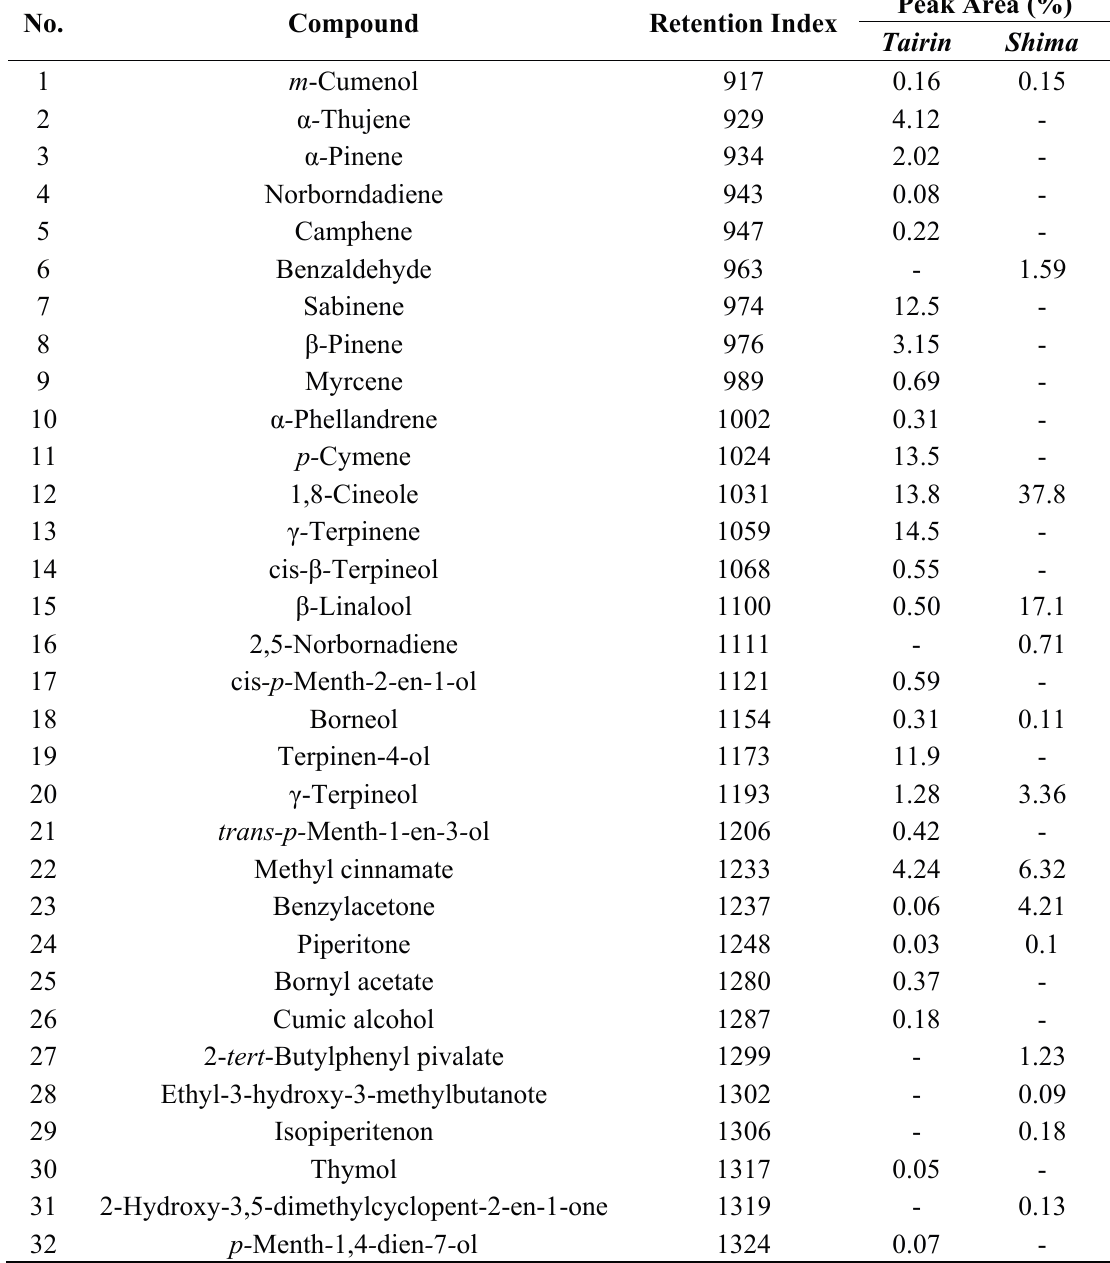
Table 1. Chemical components of the EO from two varieties of alpinia